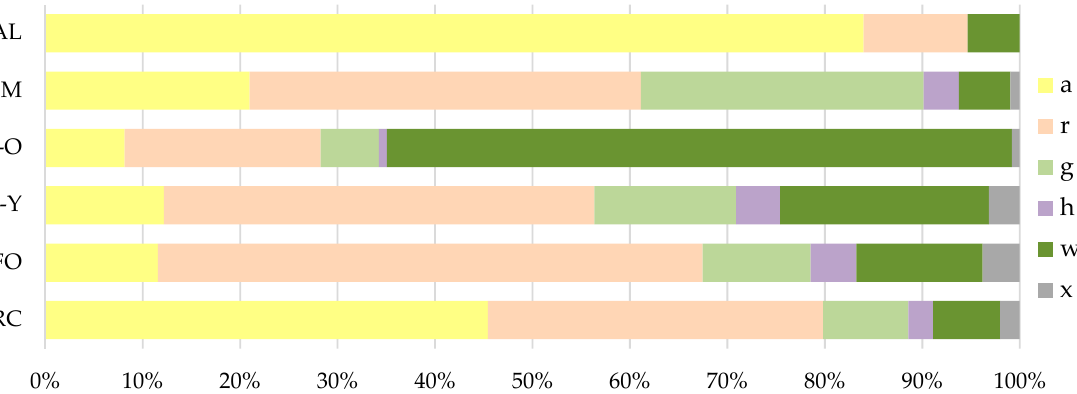
Figure 4. Proportions of plant species of different habitat preferences in the different habitat types (see Table 1 for ab-